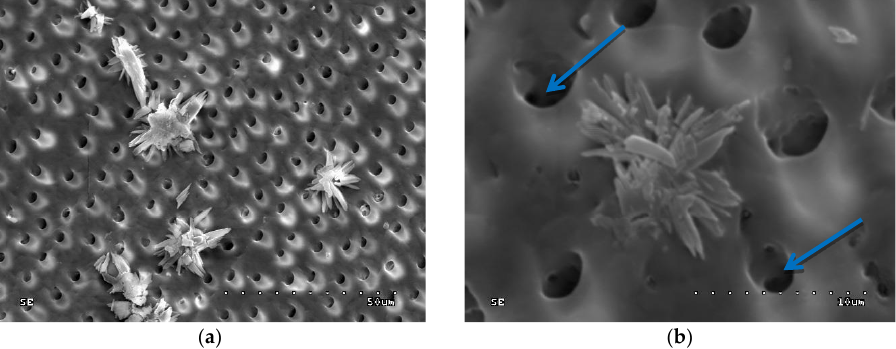
Figure 9. SEM image of acid-etched dentine surface after application of 2.0% CHG for 30 s—group 13: ( a ) 1000×; ( b ) 5000×. Blue arrows show open lateral dentinal tubules. Polymers 2018 , 10 , x FOR PEER REVIEW